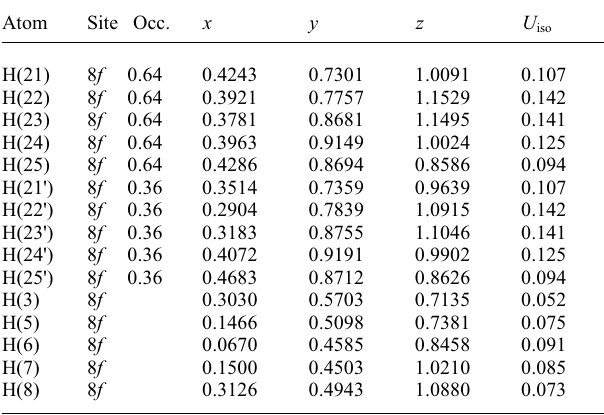
Table 2. Atomic coordinates and displacement parameters (in Å 2 )